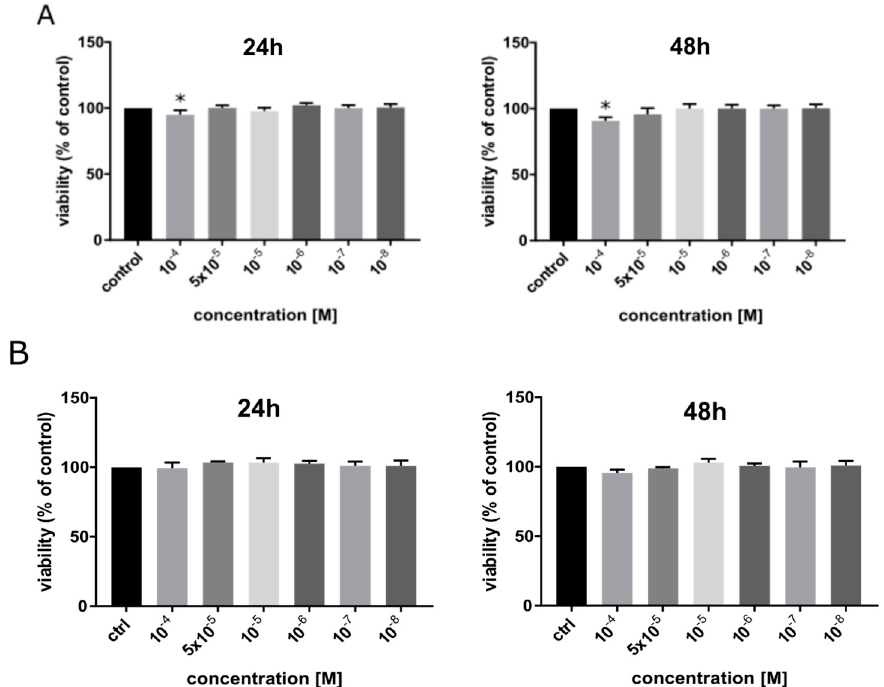
Figure 3. The viability of MCF-7 ( A ) and HDFa ( B ) cells after 24 h and 48 h treatment with ISdU in a range of concentrations from 0 M to 10 − 4 M. Results are shown as the mean ± standard deviation (SD) of three independent experiments performed in triplicate. * Statistically significant difference is present between treated samples compared with control (untreated sample).